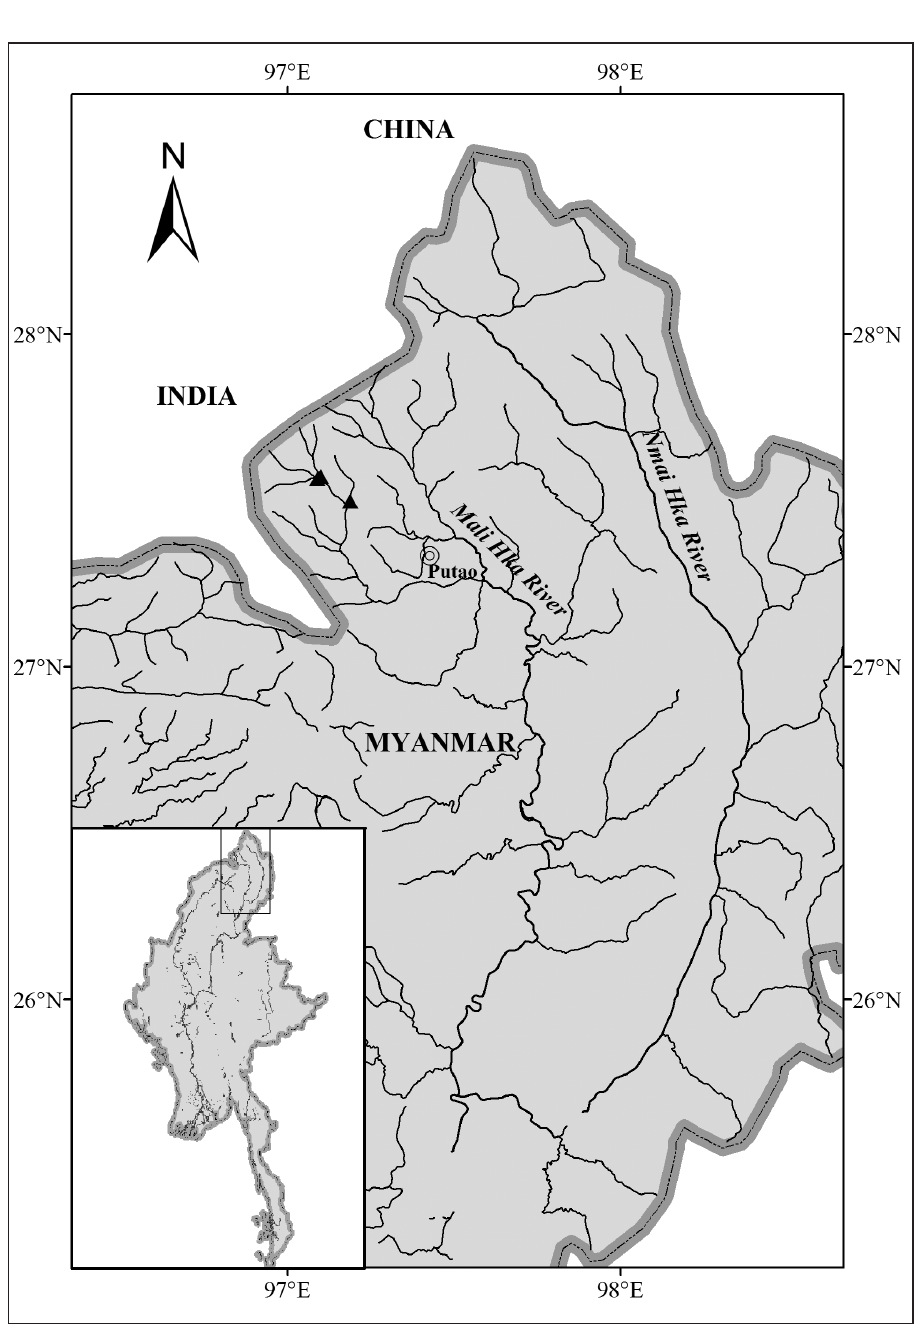
Figure 5. Distribution map of Oreoglanis hponkanensis